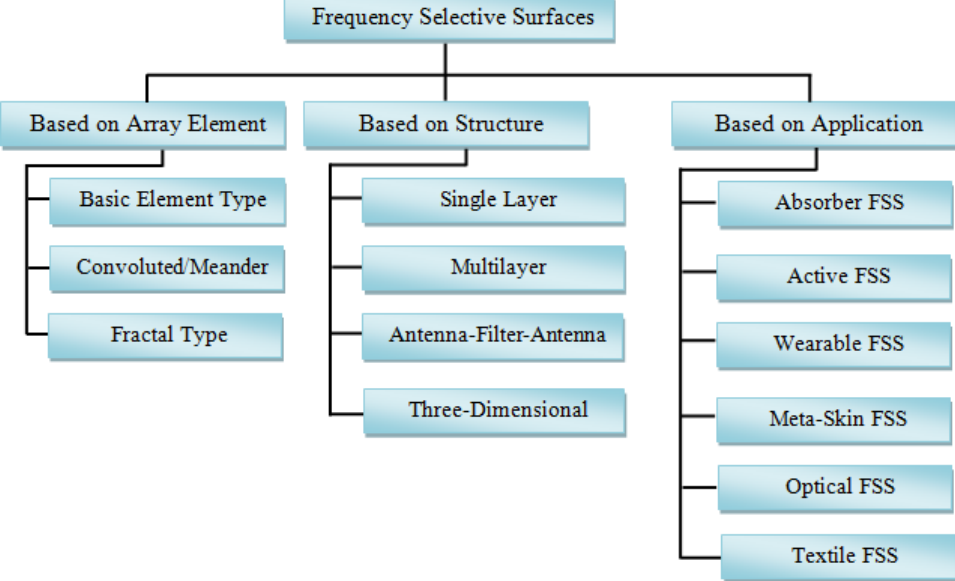
Figure 4. A taxonomy of FSSs as reviewed in this